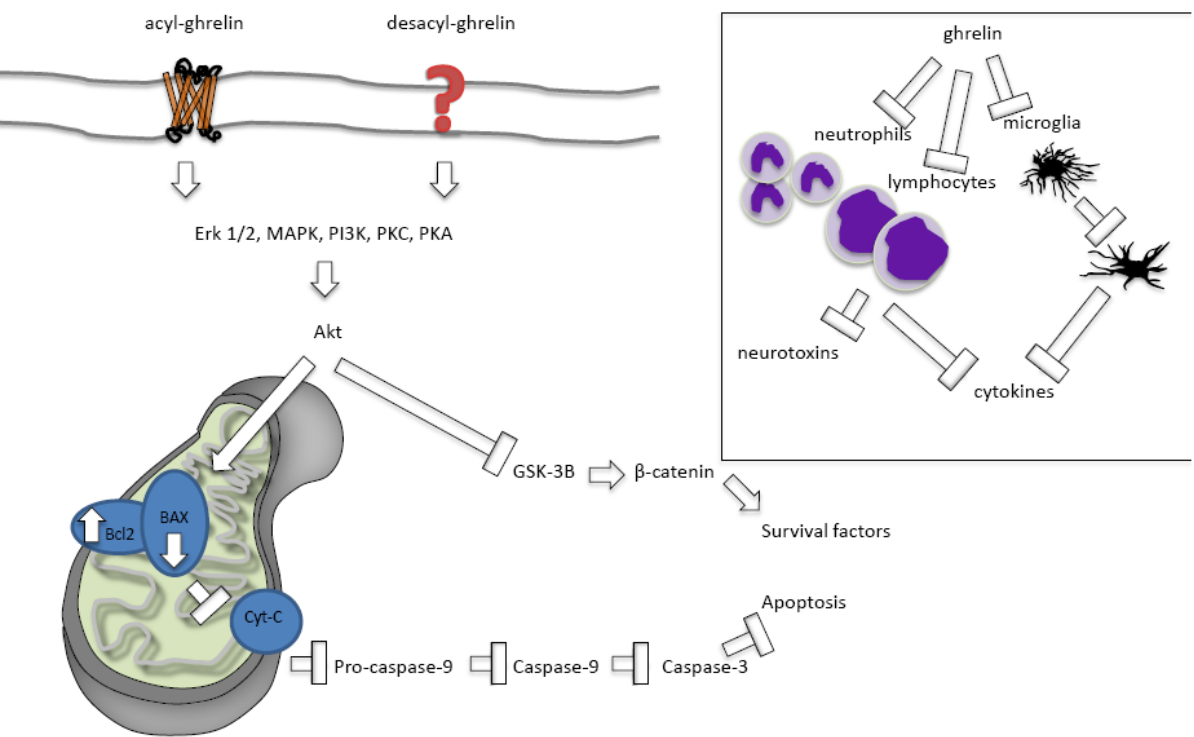
Figure 1 . Ghrelin inhibits apoptosis and protects against inflammation. Ghrelin stimulates extracellular-signalling-regulated-kinase (ERK)1/2, mitogen-activated protein kinase (MAPK), protein kinase A (PKA), and protein kinase C (PKC) pathways to reduce activation of BAX, improve the Bcl2/BAX ratio and thus suppress apoptosis and improve cell survival. Inset; ghrelin inhibits neutrophil, lymphocyte, and microglial activation to suppress pro-inflammatory cytokine production and the secretion of inflammatory